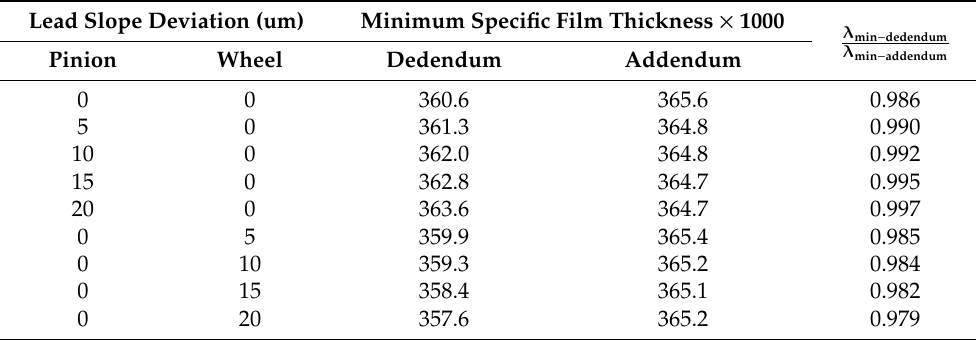
Table 8. Variation of minimum specific film thickness with di ff erent lead slope